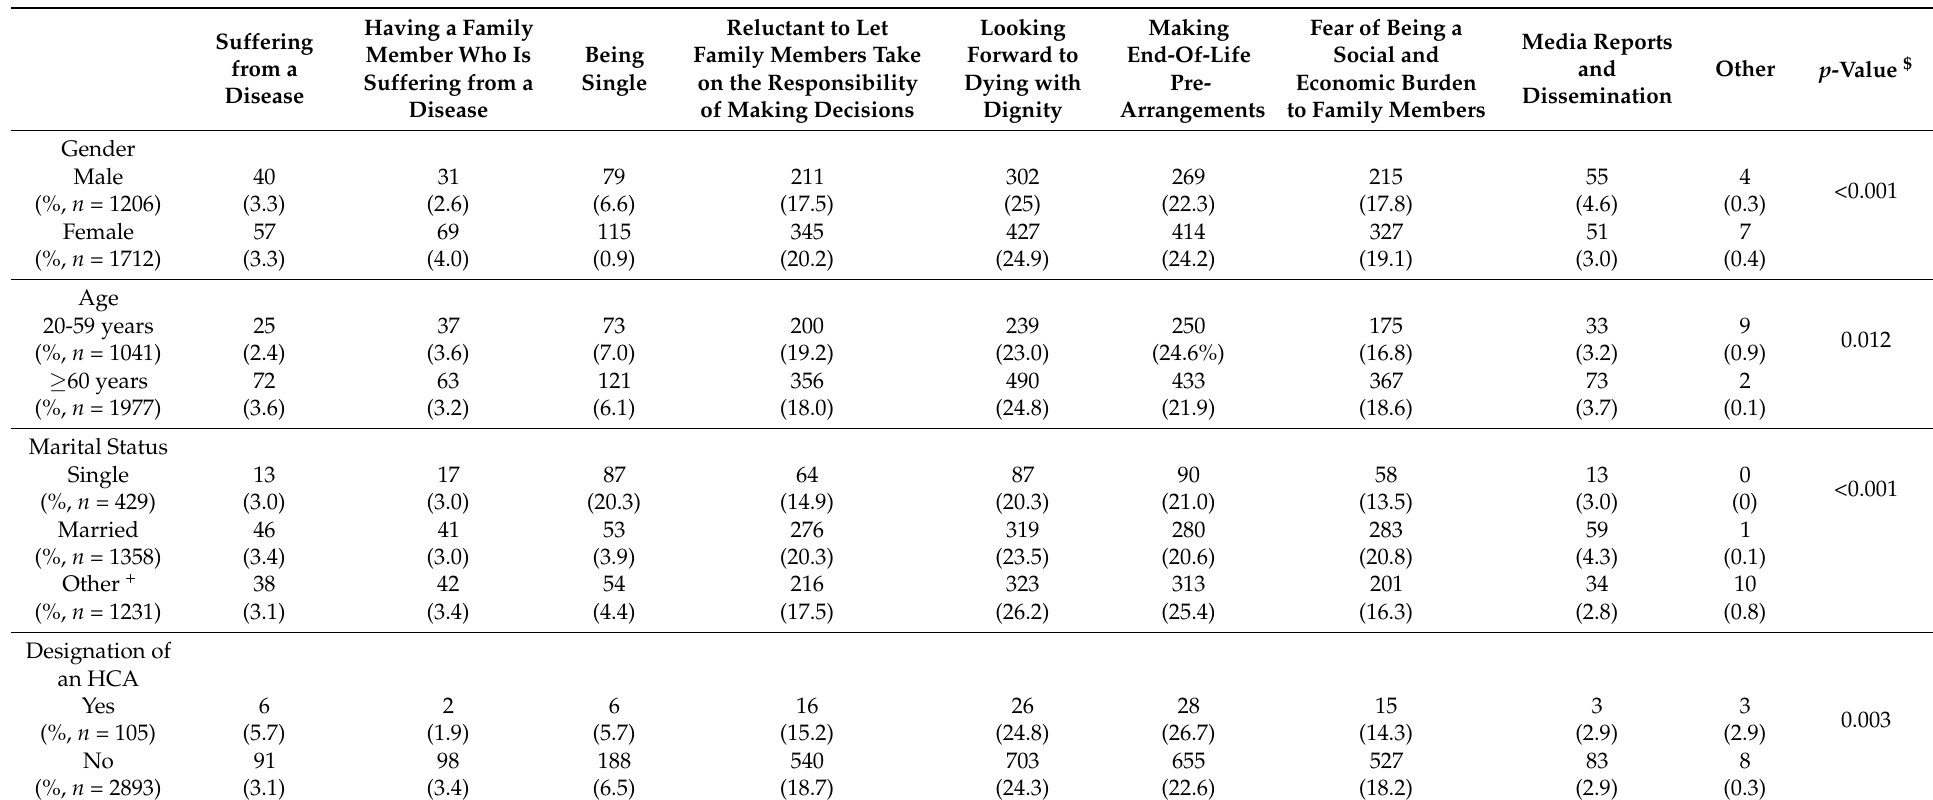
Table 2. The motivations of advance care planning participants in Taipei Veterans General Hospital in 2019